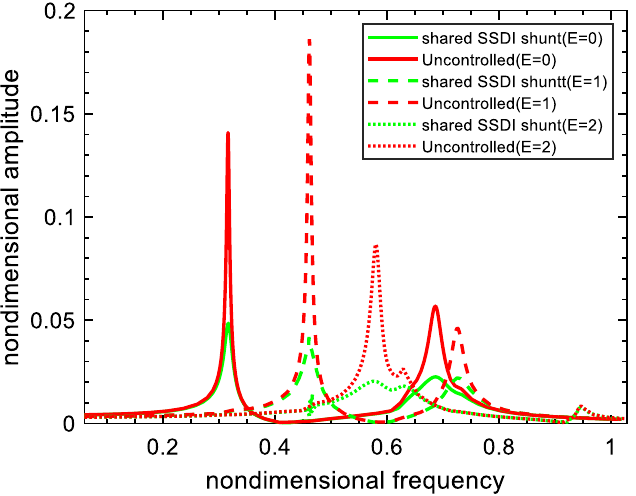
Figure 21. Forced response of the most dangerous blades under single-harmonic excitation (E = 0, 1, 2 respectively).